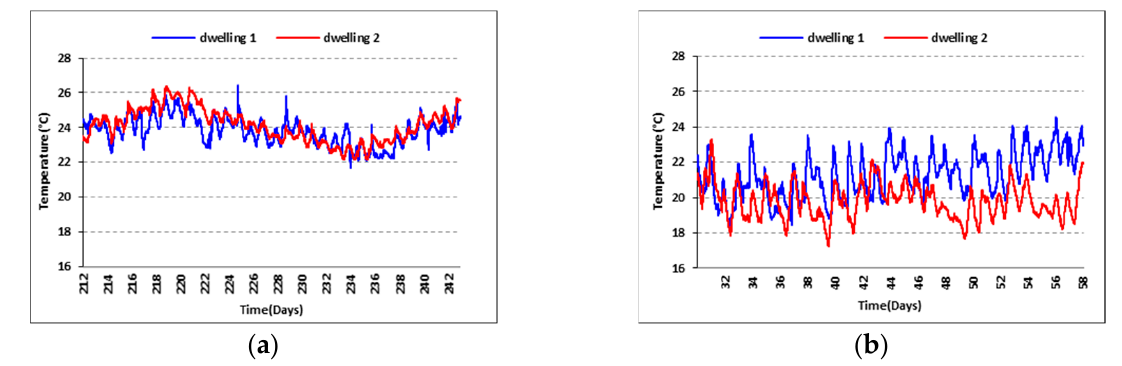
Figure 1. Average temperatures of the dwellings. Examples for typical months in summer and winter: ( a ) August 2014; ( b ) February